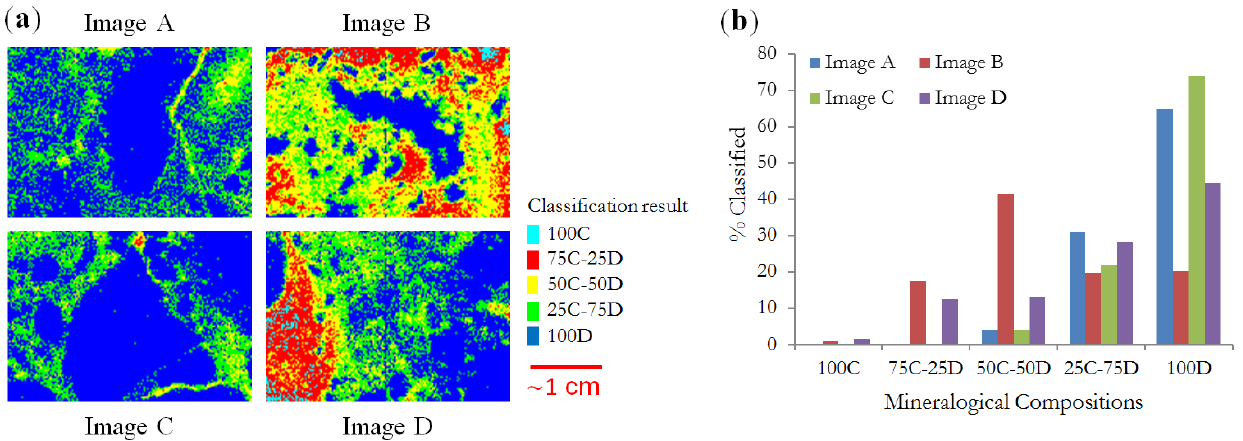
Figure 6. ( a ) Wavelength position images, showing the variability carbonate mineral mixtures. ( b ) Estimated proportion of classified minerals derived from the images. (C = calcite and D = dolomite, prefix numbers showing the mineral contents in